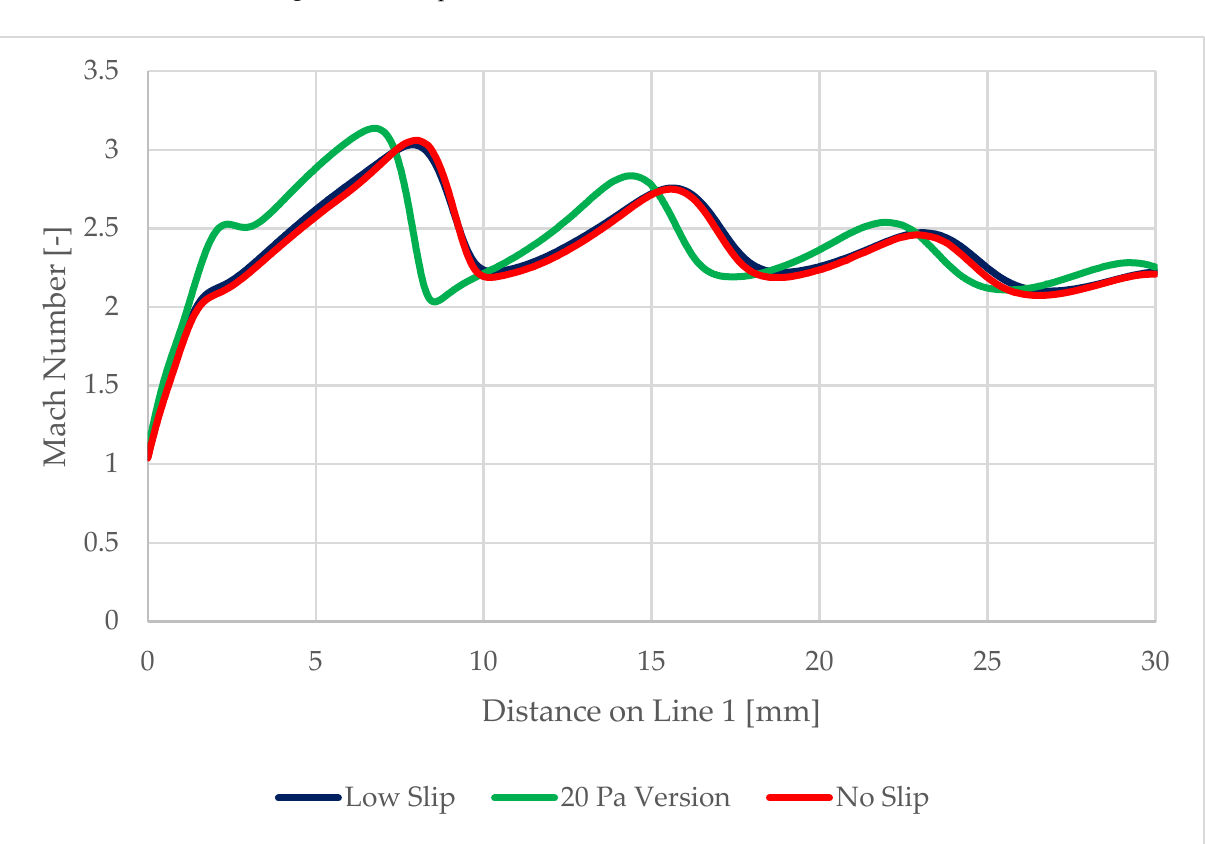
Figure 18. Static pressure distribution on Line 1.